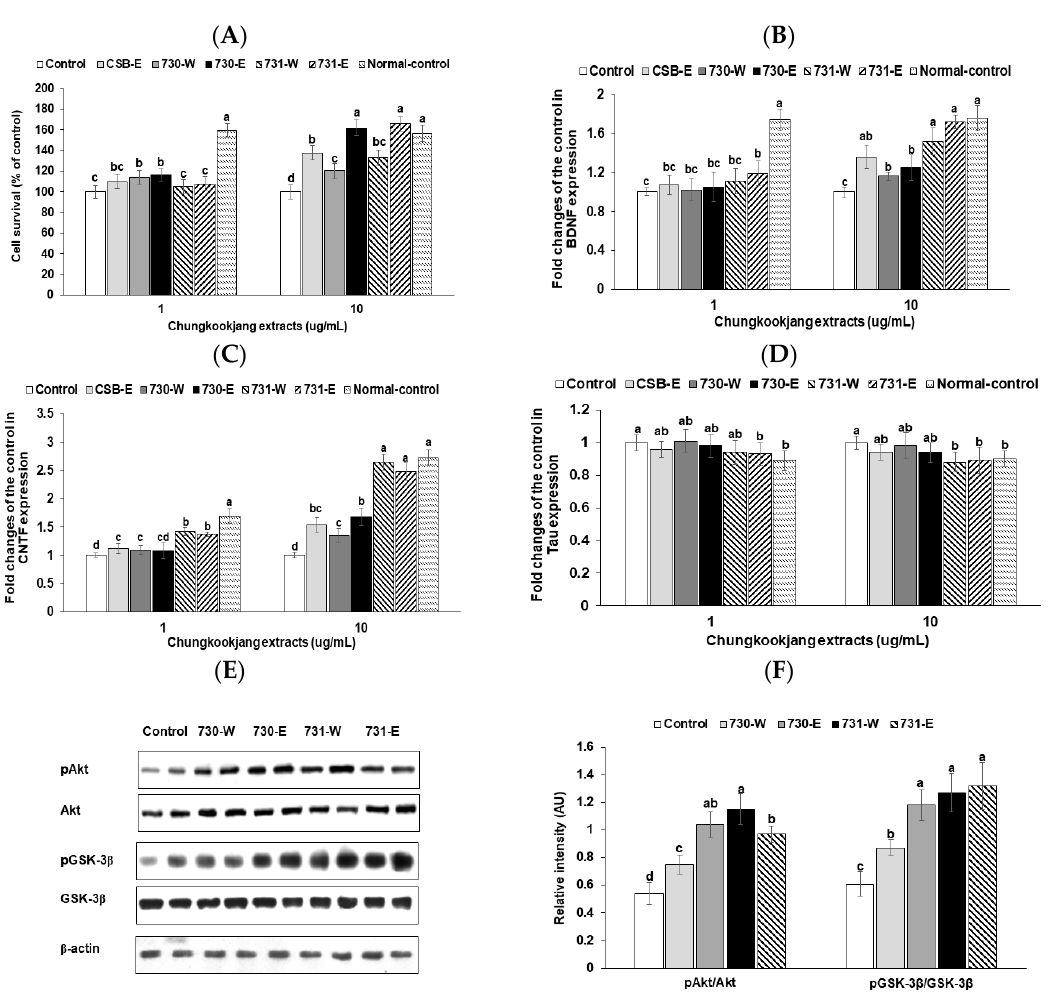
Figure 5. Cell survival and mRNA expression of genes associated with neurogenesis in differentiated PC12 cells. PC12 cells were differentiated with nerve growth factor (NGF) for 2 days and differentiated PC12 cells were administered with amyloid- β (25–35) for additional 2 days. The PC12 cells had treatments with a vehicle or 5 µ g · mL − 1 of 70% ethanol (-E) or water extracts (-W) of chungkookjang fermented with B. amyloliquefaciens SRCM100730 (BA730) and SRCM100731 (BA731). Cell survival ( A ) was measured after 24 h treatment. The cDNA was generated from the cells and the fold changes of mRNA levels of BDNF ( B ), CNTF ( C ), and tau ( D ) from the control were calculated by the 2 − ∆∆ CT method after conducting real-time PCR. The phosphorylation of Akt and GSK-3 β was conducted by immunoblooting and intensity of the blots was measured ( E ). Immunoblot assay was performed with high dosage of assigned chungkookjang extracts. The relative intensity of phosphorylation of Akt and GSK-3 β was given ( F ). Values are means ± SD ( n = 7). a,b,c,d Different letters above the bars indicate significant differences among the groups by Tukey’s test at p < 0.05.